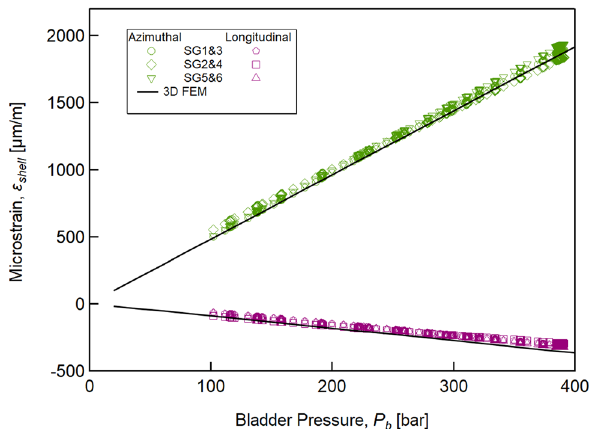
Figure 9. The azimuthal (green markers) and longitudinal (purple markers) strains measured at room temperature as a function of the pressure in the bladder (markers). The 3D FEM model (continuous black lines) reproduces the experimental linear behaviour with sufficient